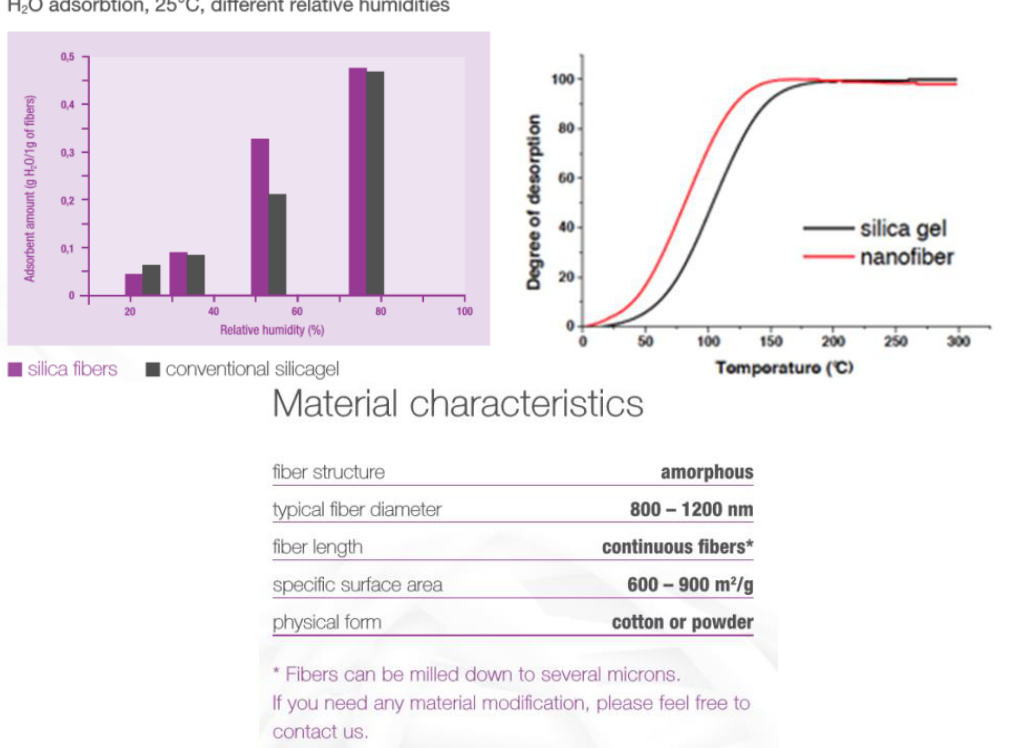
Figure 18. Comparison of the water adsorption on porous SiO 2 nanofibers and on silica gel independence of relative humidity ( left ) and desorption of water from porous SiO 2 nanofibers ( right )and silica gel dependent on temperature; and parameters of porous SiO 2 nanofibers ( down-center ).